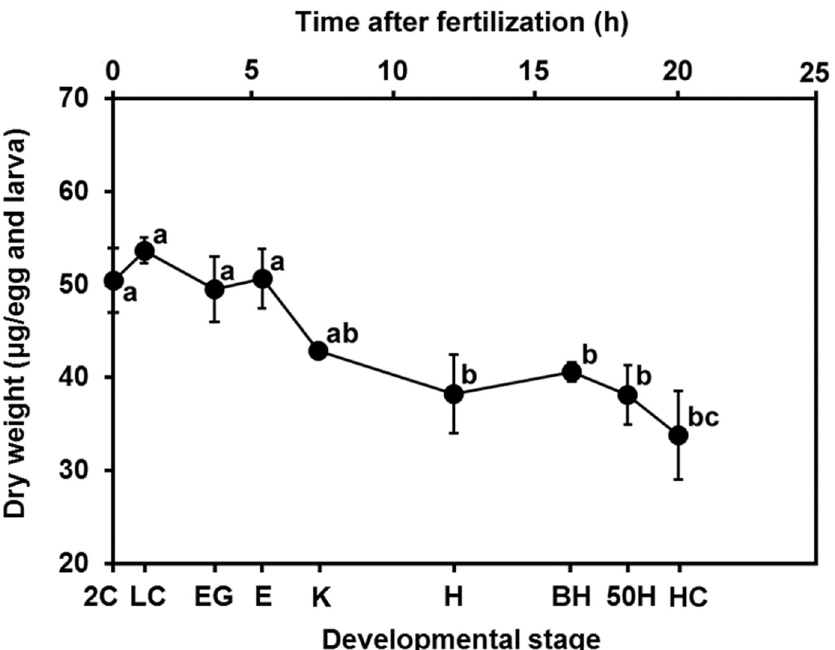
Figure 2. Changes in the dry weight of eggs and larvae of yellowfin tuna. Values are presented as means ± SD. Letters next to values denote significant differences ( p < 0.05). Abbreviations of developmental stages: 2C = 2 cells; LC = late cleavage; EG = early gastrula; E = appearance of embryonic shield; K = appearance of Kupffer’s vesicle; H = beginning of heart beat; BH = just before hatching; 50H = 50% hatching; and HC = hatching complete. The time elapsed at each embryonic stage, 2C, LC, EG, E, K, H, BH, 50H, and HC, is 0, 1.1, 3.6, 5.3, 7.3, 12.1, 16.3, 18.3, and 20.1 h, respectively.